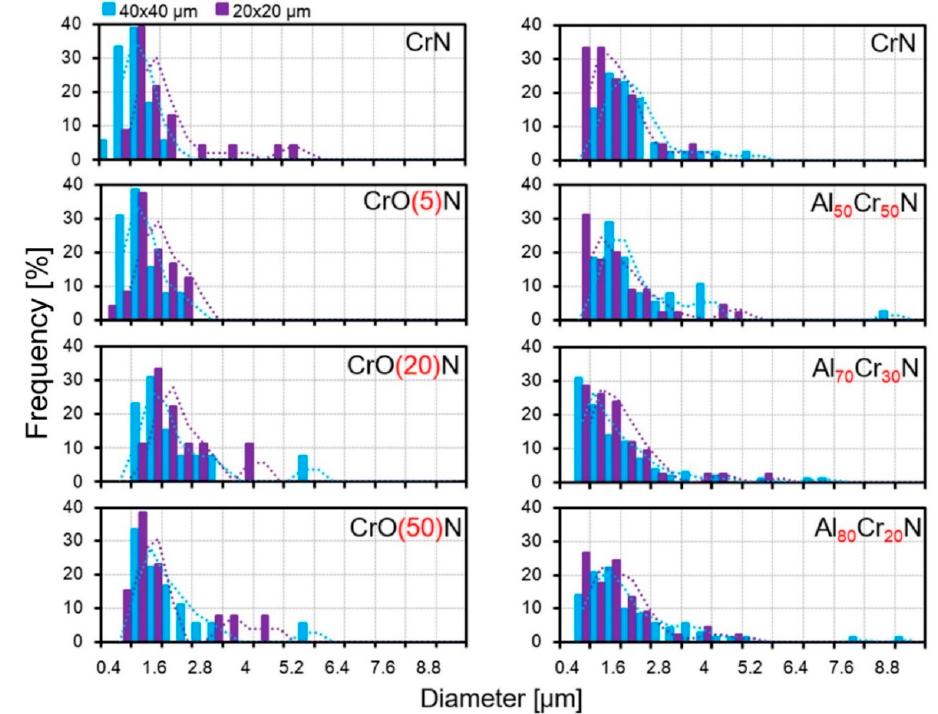
Figure 7. Histograms of the microparticle diameters of the AlCrN and CrON coatings in the fields of 40 × 40 µm 2 and 20 × 20 µm 2 . Nanomaterials 2020 , 10 , x FOR PEER REVIEW